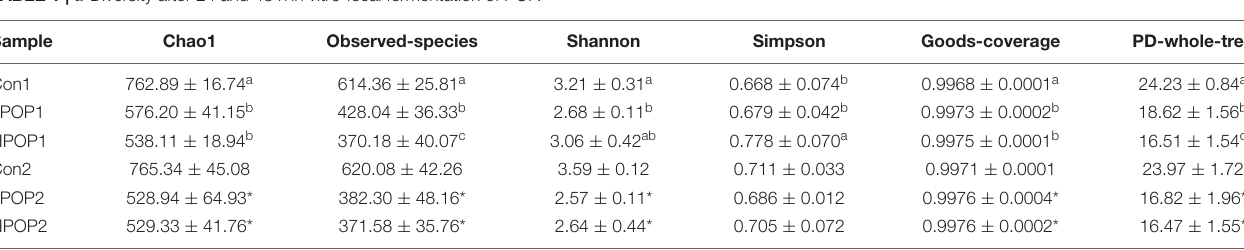
TABLE 1 | α -Diversity after 24 and 48 h in vitro fecal fermentation of